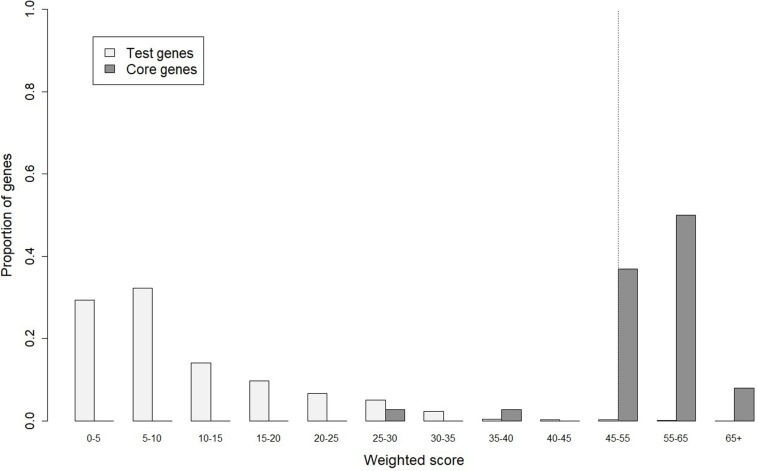
The optimal cut-off score in separating distributions of weighted scores between the test genes and the core genes.